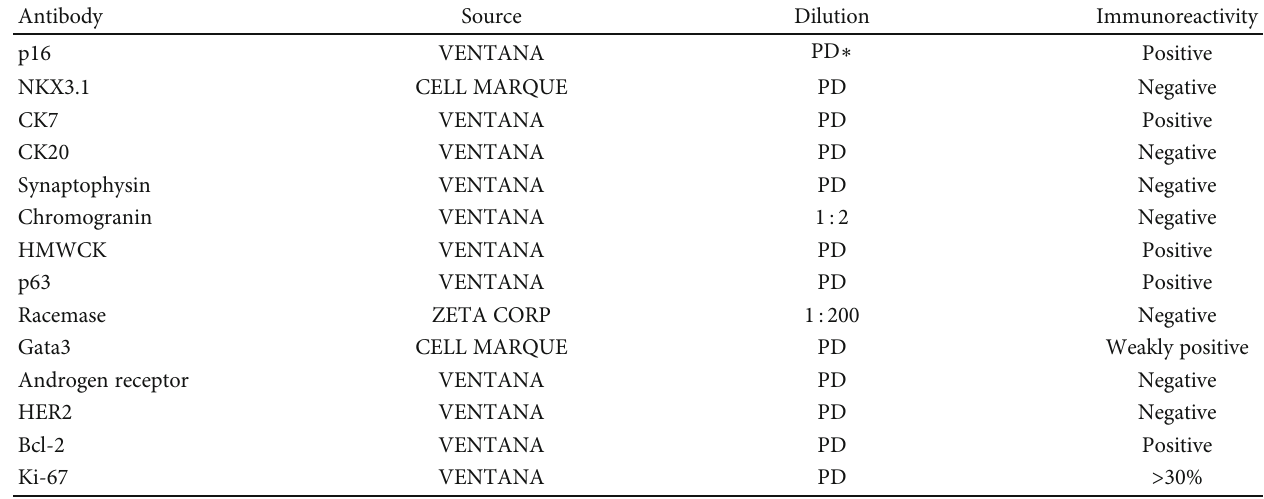
Table 1: Immunohistochemical antibody